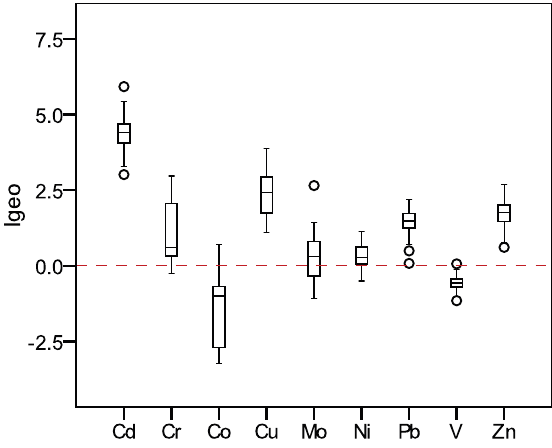
Figure 2. The I geo of heavy metals of